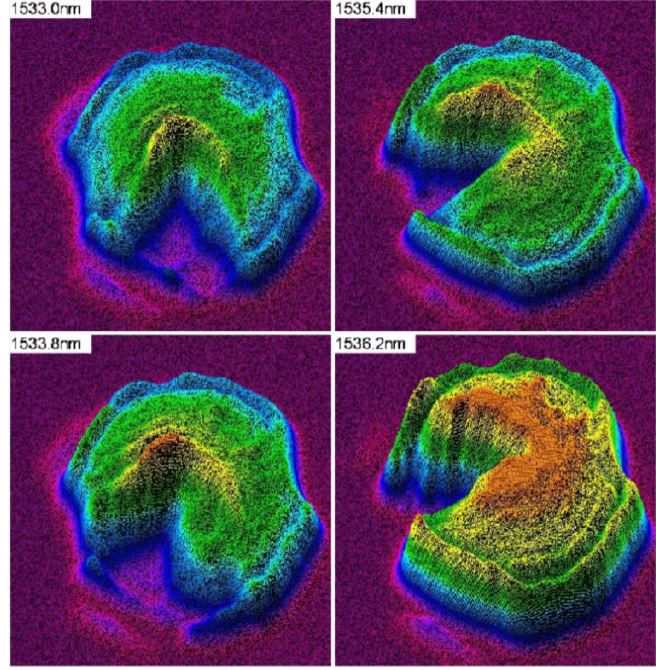
Figure 16. The transmitted beam profiles at four different